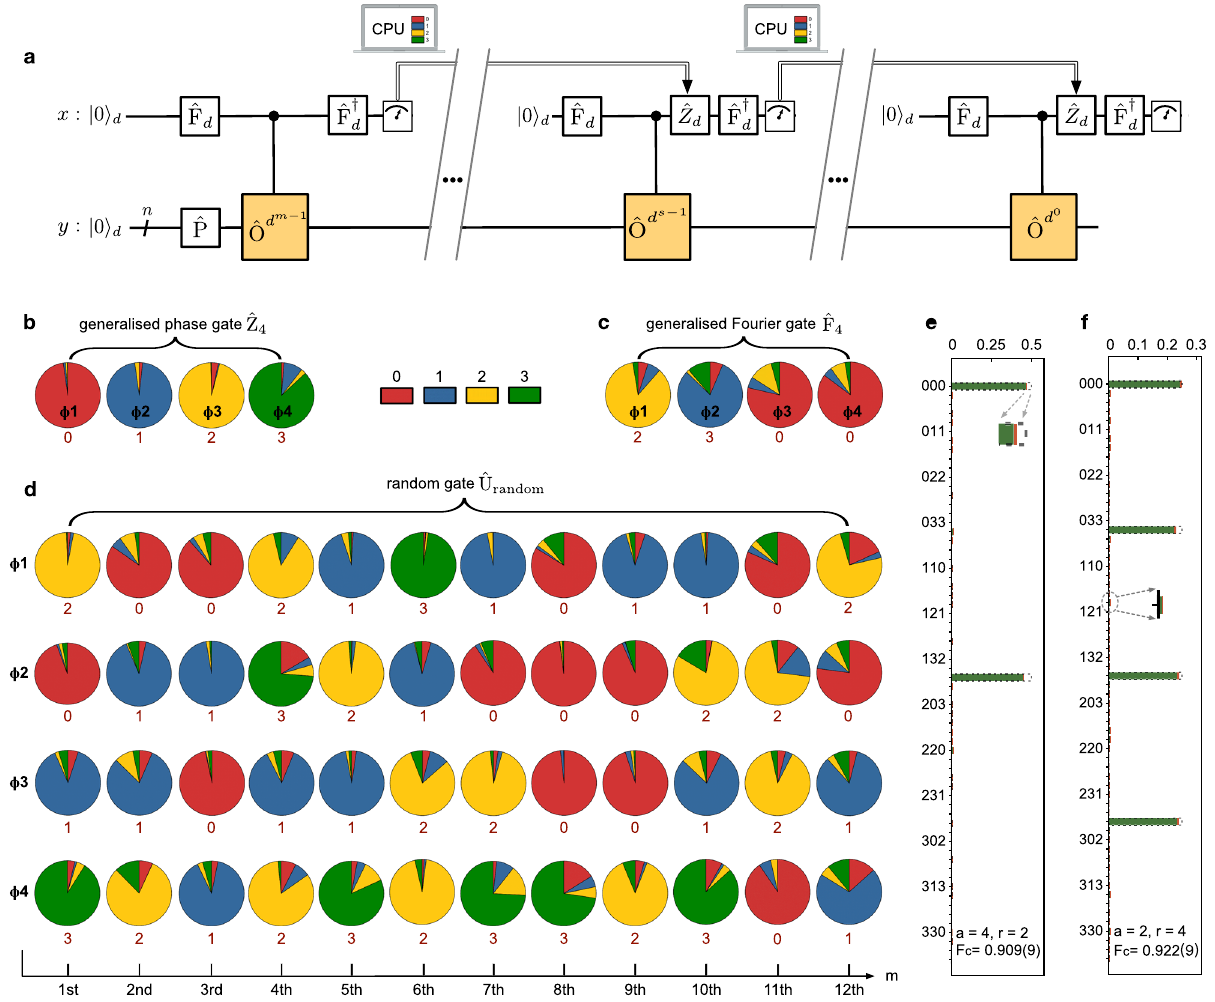
Fig. 5 Implementations of quaternary quantum phase estimation and order- fi nding. a Their quantum logical circuit for implementing Kitaev ’ s scalable approaches. For the d -ary phase estimation, the task is to compute the eigenphase ϕ of a unitary O given its eigenstate of ϕ the task is to fi nd the order of a function as ( a r mod N ) = 1. The x -register single-qudit state is initialised by the Fourier gate F d ; the y -register is prepared in (cid:1) (cid:3) (cid:1) eigenstate ( 0 j i (cid:3) n d state) for phase estimation (for order- fi nding). The F y d terminates the x -register to output the desired solution in the the ϕ computational basis. In the s -th step, the Z d rotation is added with a feedback angle of θ s = − 0.0 ϕ s + 1 ϕ s + 2 … ϕ m , that is determined by previous measurements. The algorithm is iterated m times -- each step returns 1 dit result with d -ary accuracy, to obtain a m -dit estimation of the eigenphase of a unitary or the order of a function. b – d Measured probability pie-distributions of the four eigenphases ( ϕ 1 , ϕ 2 , ϕ 3 , ϕ 4 ) for three different unitary matrices, using the quaternary quantum phase estimation: b a generalised phase gate Z 4 as diag[1 ; e i 2 πθ ; e i 2 π 2 θ ; e i 2 π 3 θ ] where θ = 1/4; c a generalised Fourier gate F 4 ; d a random gate U random (see form in Supplementary Note 5). Coloured sectors represent the experimental outcomes of {0,1,2,3} for each iteration, measured in the computational basis of { 0 j i , 1 j i , 2 j i , 3 j i }, respectively. The measured dominating sector is used to obtain every dit of the eigenphases; theoretical values for each dit are provided under the pies. The eigenphases are backwardly computed from the least signi fi cant dit from m = 12 to 1. e , f Measured probability distributions for the quaternary order- fi nding algorithm with a setting of a = 4 and a = 2, respectively. From the distributions, the order of r = 2 and r = 4 are experimentally computed with a 3-quart resolution (equivalent to 64-level), and with a classical statistic fi delity ( F c ) of 0.909(9) and 0.922(9), respectively. The order- fi nding together with classical algorithm allows the factorisation of 15 = 3 × 5. Errors ( ± 1 σ ) arising from photon Poissonian noise are indicated as red shaded caps. Dashed lines refer to theoretical predictions. Experimental probability distributions in b – f are calculated from photon coincidences, which are accumulated by 20s per